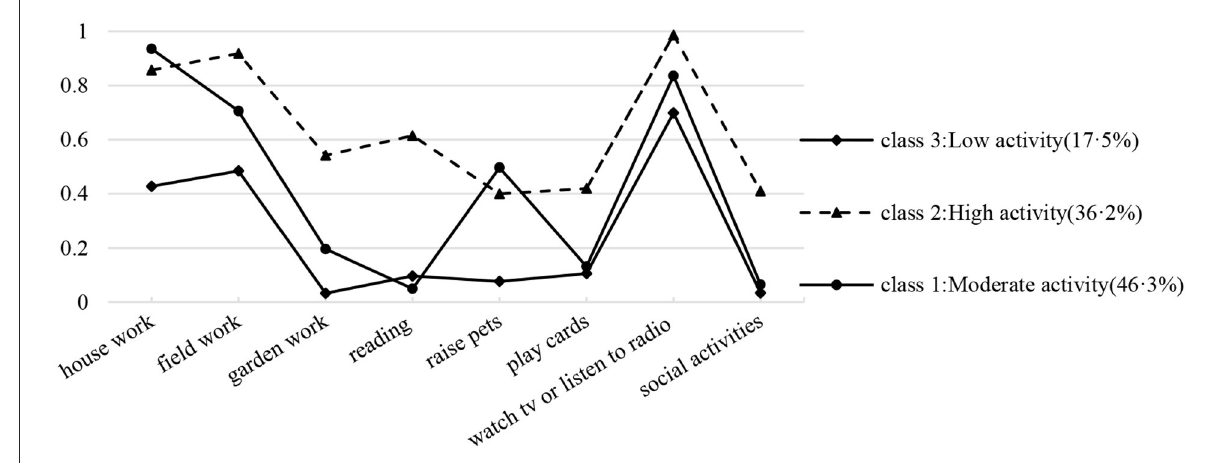
FIGURE2 Conditional probability distribution for three categories of social participation ( N =